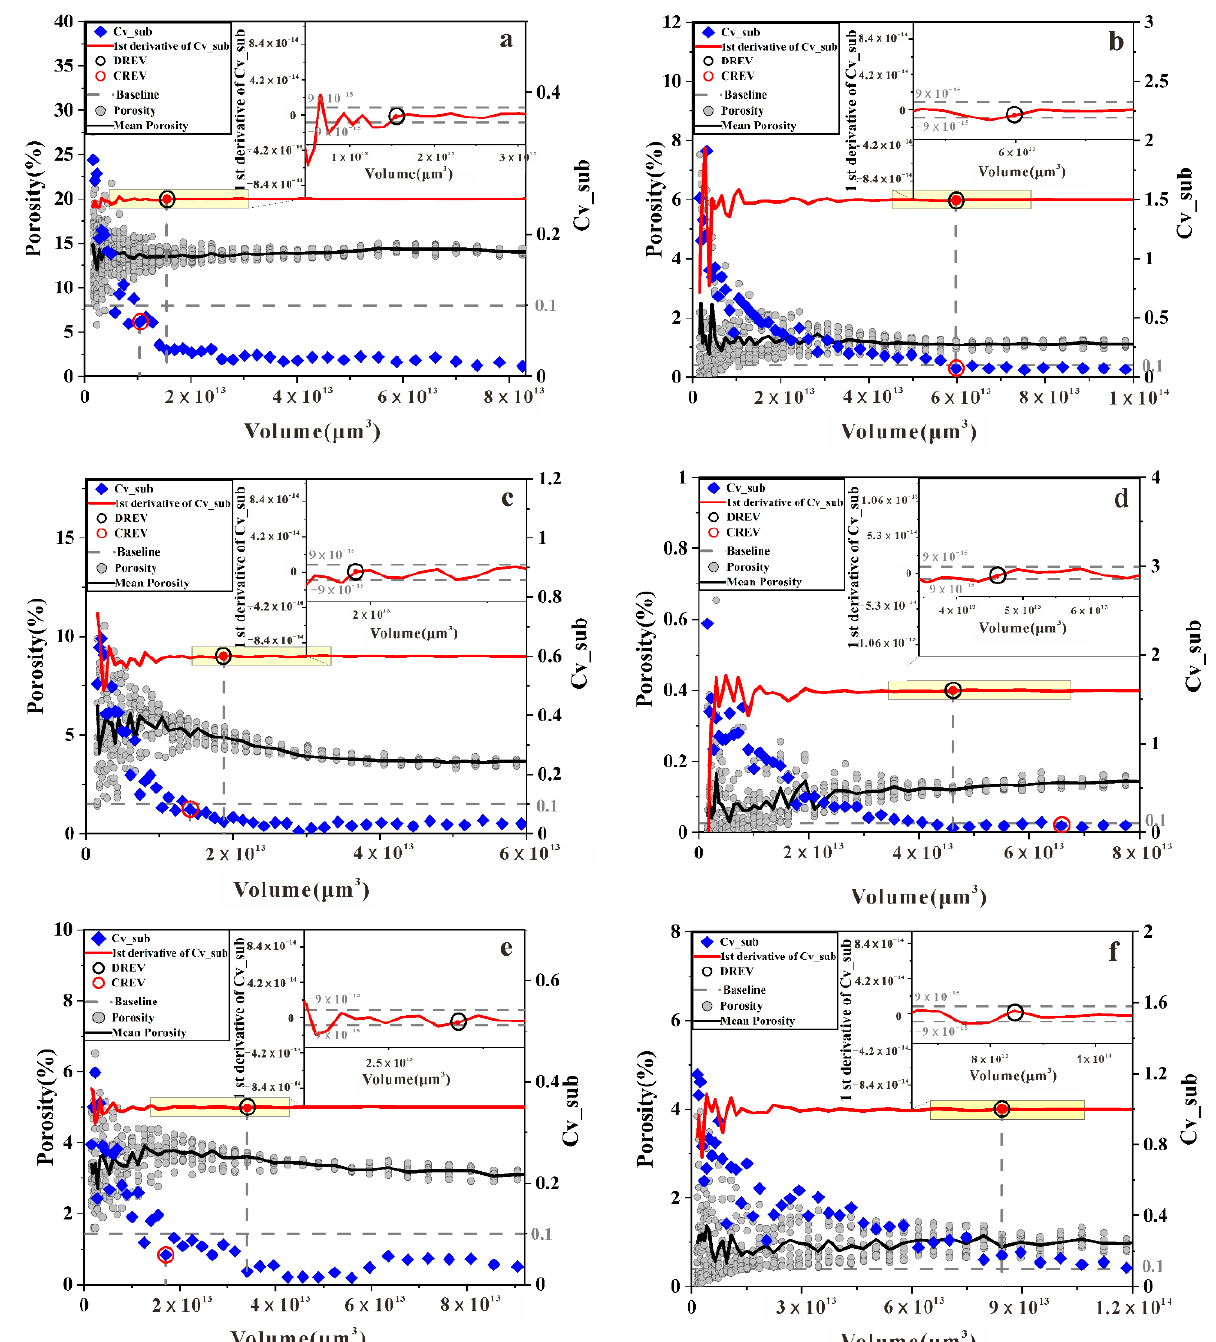
Figure 13. Determination of REV for porosity. ( a ) Sample SHY002 developed flat vugs with a diameter of 2–6 mm. ( b ) Sample SHY007 developed vugs and cracks, and vugs half-filled by secondary carbonates. ( c ) Sample SHY009 developed a multitude of flat vugs developed with a diameter of 3–4 mm. ( d ) Sample SHY014 developed small amount of vugs with a diameter of 0.5–1 mm. ( e ) Sample SHY022 developed a multitude of flat vugs with a diameter of 1–2 mm. ( f ) Sample SHY025 developed flat vugs with a diameter of 2–6 mm and partially filled by secondary carbonates. The insets in the six images are magnifications of light yellow rectangle indicated in individual images.